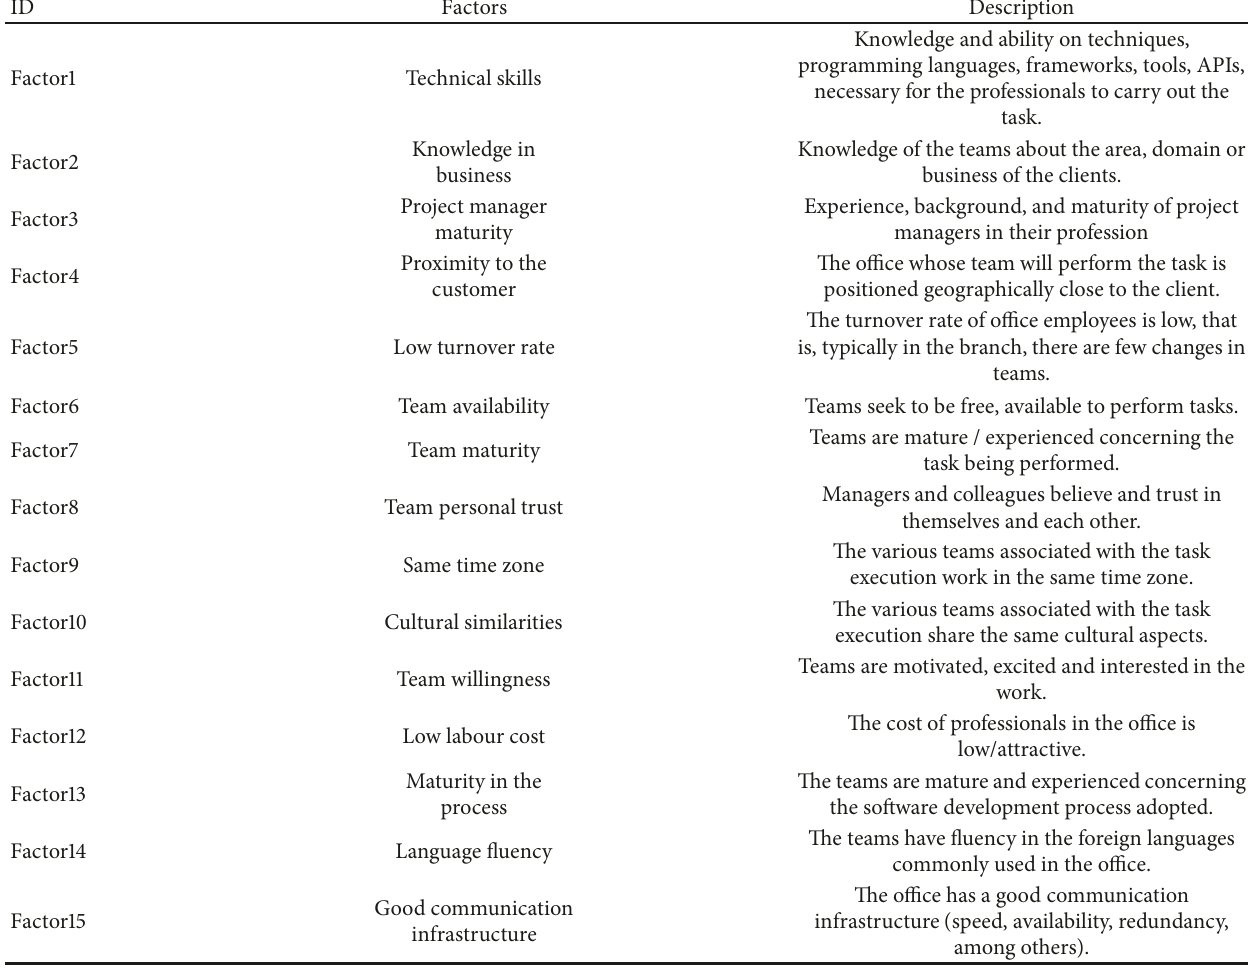
Table 4: Influencing factors on task allocation in DSD